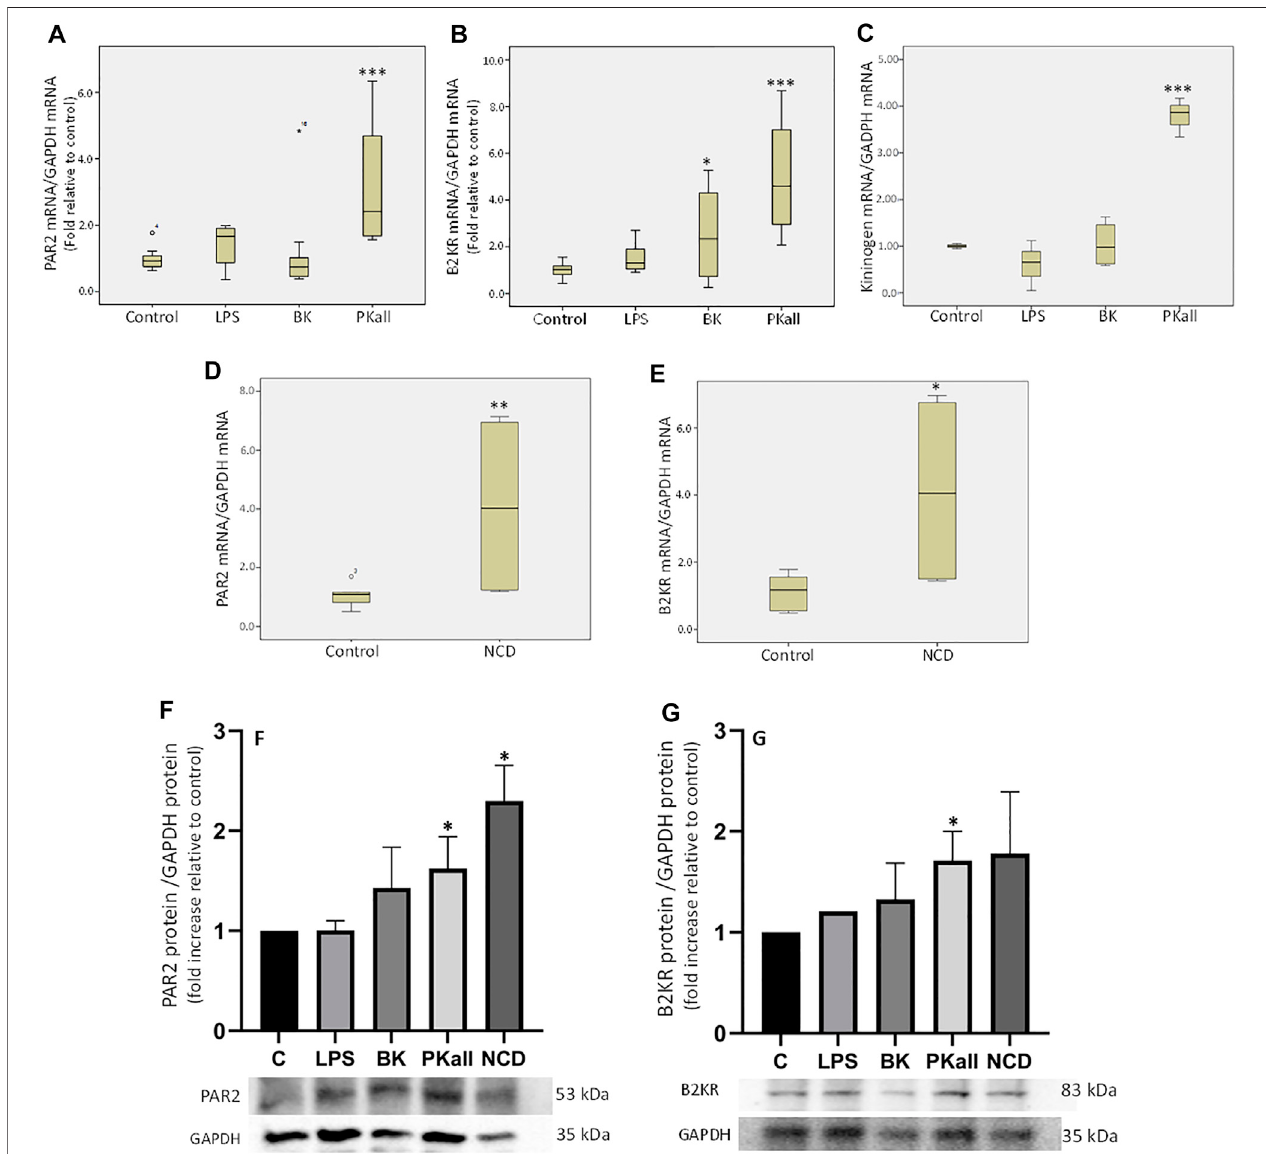
FIGURE 1 | Expression of components of the plasma kallikrein-kinin system (PKKS) in microglial cells. Microglial cells grown in 2% FBS were stimulated with LPS (100 ng/ml), BK (0.1 µM), PKall (2.5 ng/ml) and NCD (16.5 µg protein/ml) for 24 h. The boxplots demonstrate the mRNA levels of (A) PAR 2, (B) B2KR and (C) KNG expressed relativetoGAPDHmRNAlevelsassessedconcomitantlyatthesametimeinthesamesamples(* p ≤ 0.05,*** p ≤ 0.005vs.Control, n (cid:1) 5 – 7).Theboxplots (D) PAR 2 and (E) B 2 KR, demonstrate the mRNA levels ofthesereceptors expressed relative to GAPDH mRNA levels assessed concomitantly at the same time in the same samples in response to neuronal cell debris (* p ≤ 0.04, ** p ≤ 0.033 vs. Control, n (cid:1) 5). The bar graphs (F) and (G) represent the protein expression of PAR2 and B 2 KR relative to GAPDH protein levels measured concomitantly at the same time in the same samples in response to LPS, BK, PKall, and NCD (* p ≤ 0.04 vs. C, n (cid:1) 4).